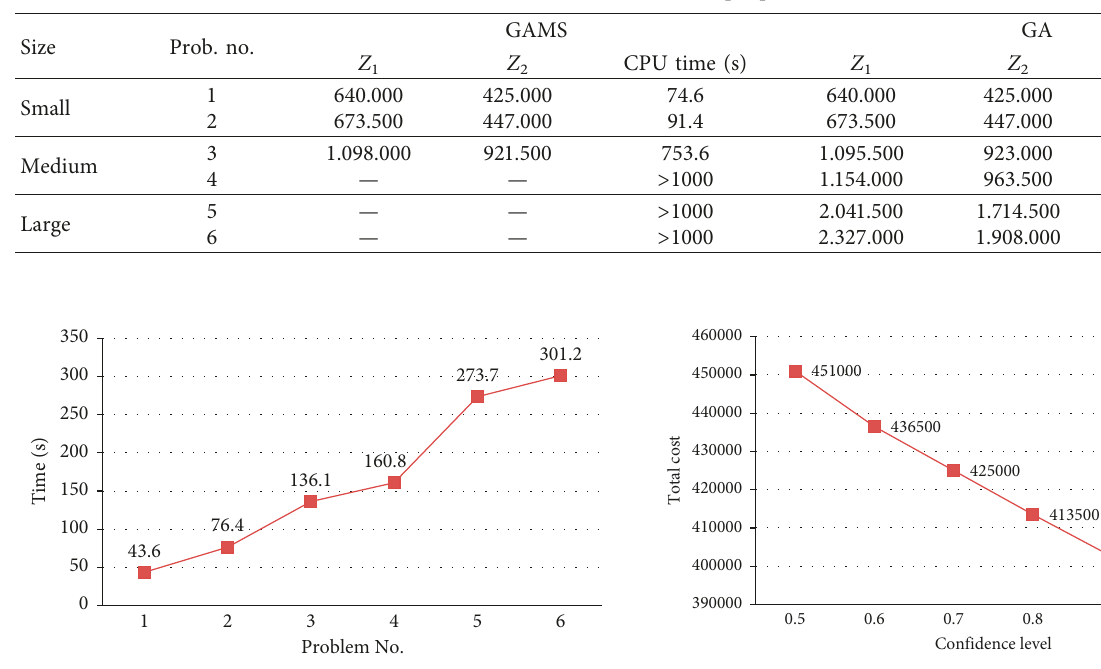
Table 6: Solution results of sample problems.